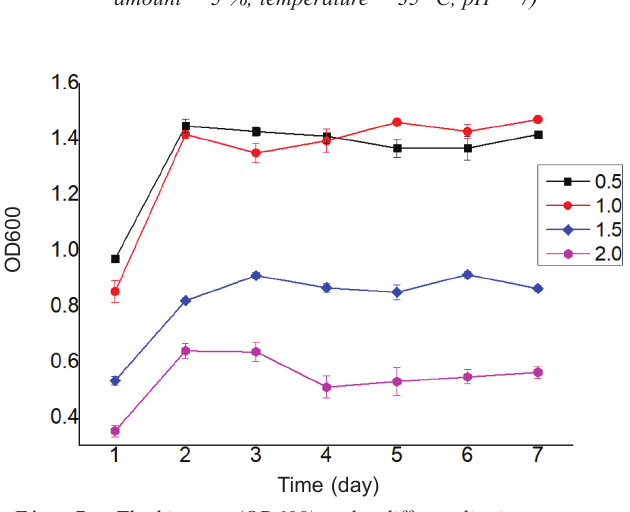
Fig. 7 – The biomass (OD600) under different lignin concen­